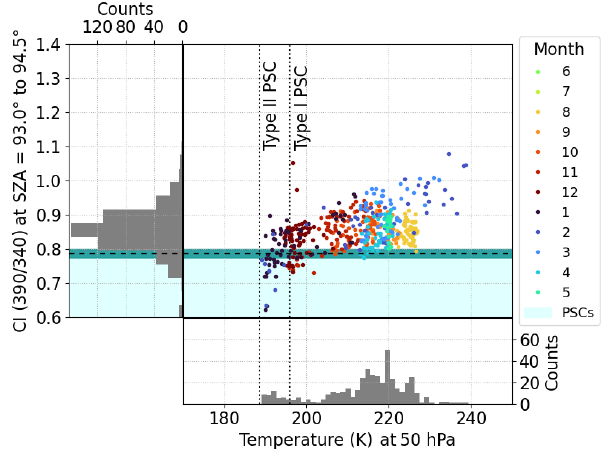
Figure 9. Colour index (CI) in the UV of the year 2017 for the Kiruna measurements. Data are represented as in Fig. 7, but no tro- pospheric cloud filter was